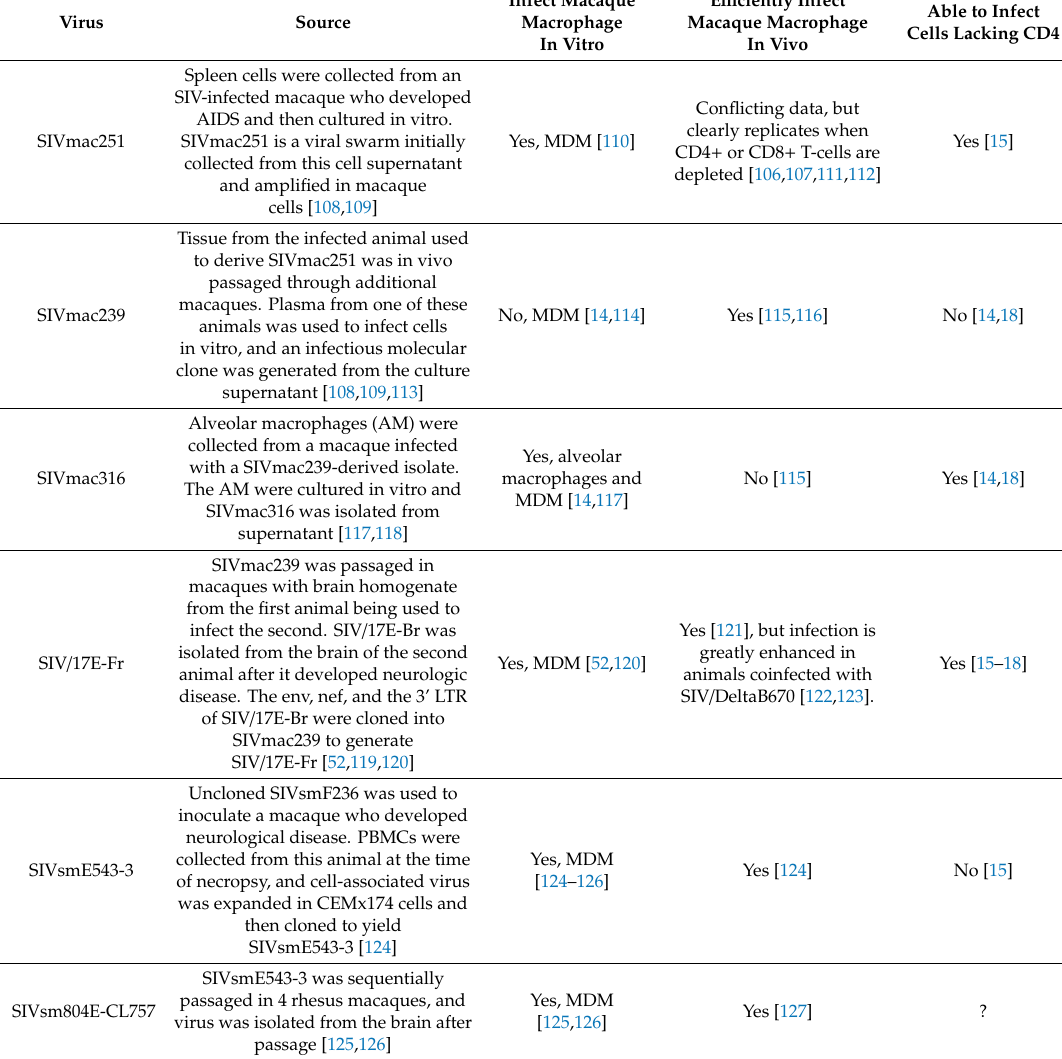
Table 2. Macrophage tropism of SIVs commonly used in NHP models of HIV